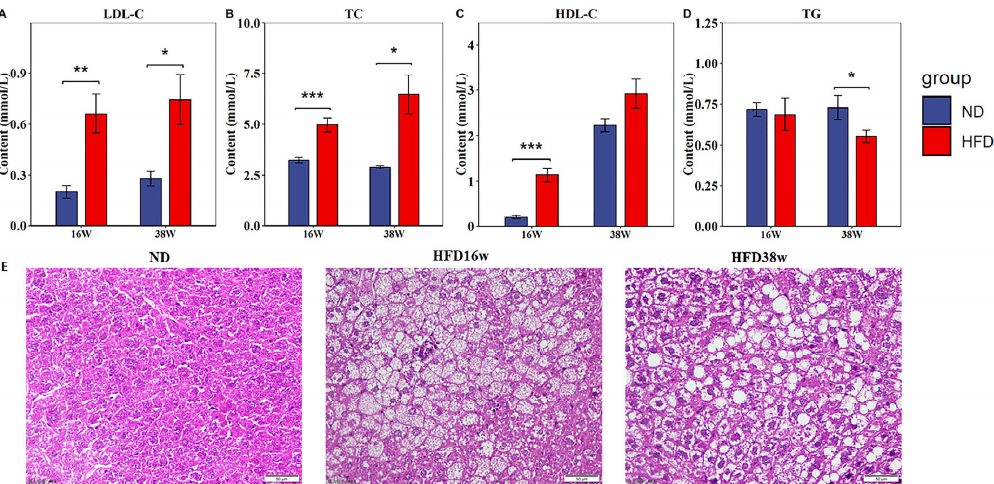
Figure 2. Effects of a high ‐ fat diet on lipid metabolism in mice. ( A – D ) Thirty ‐ eight weeks of a high ‐ fat diet significantly increased the levels of serum LDL ‐ C, TC, HDL ‐ C A ‐ D and TG in the model group. ( E ) HE staining of liver tissues in the model group and the control group showed that there were fat vacuoles in the liver, which caused liver lipid accumulation (400 × ) (* p < 0.05, ** p < 0.01, *** p < 0.001).